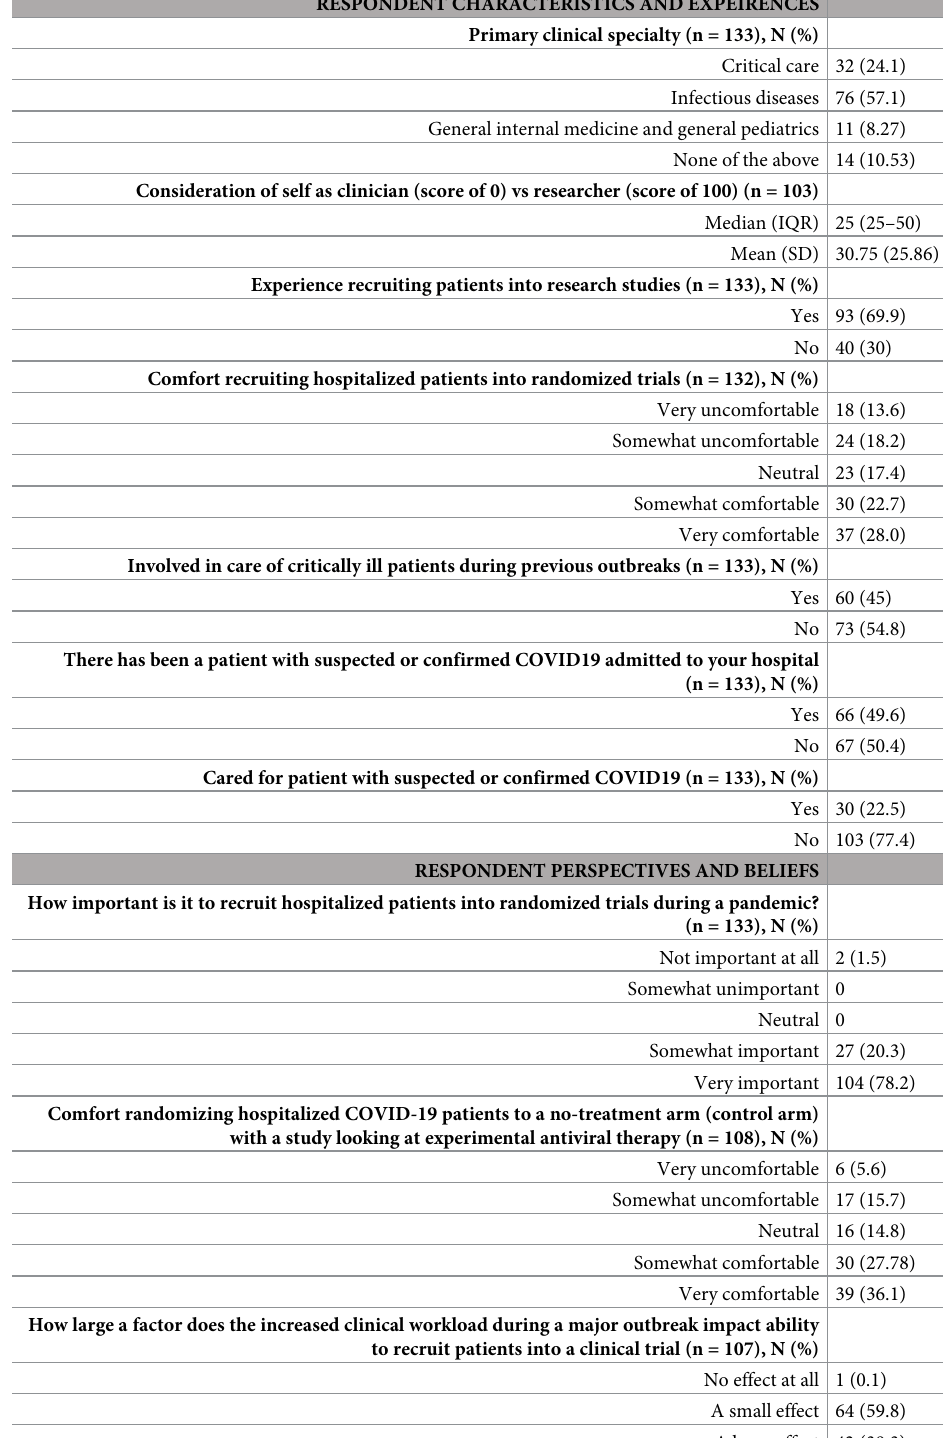
Table 1. Respondent experience and baseline perspectives on research during